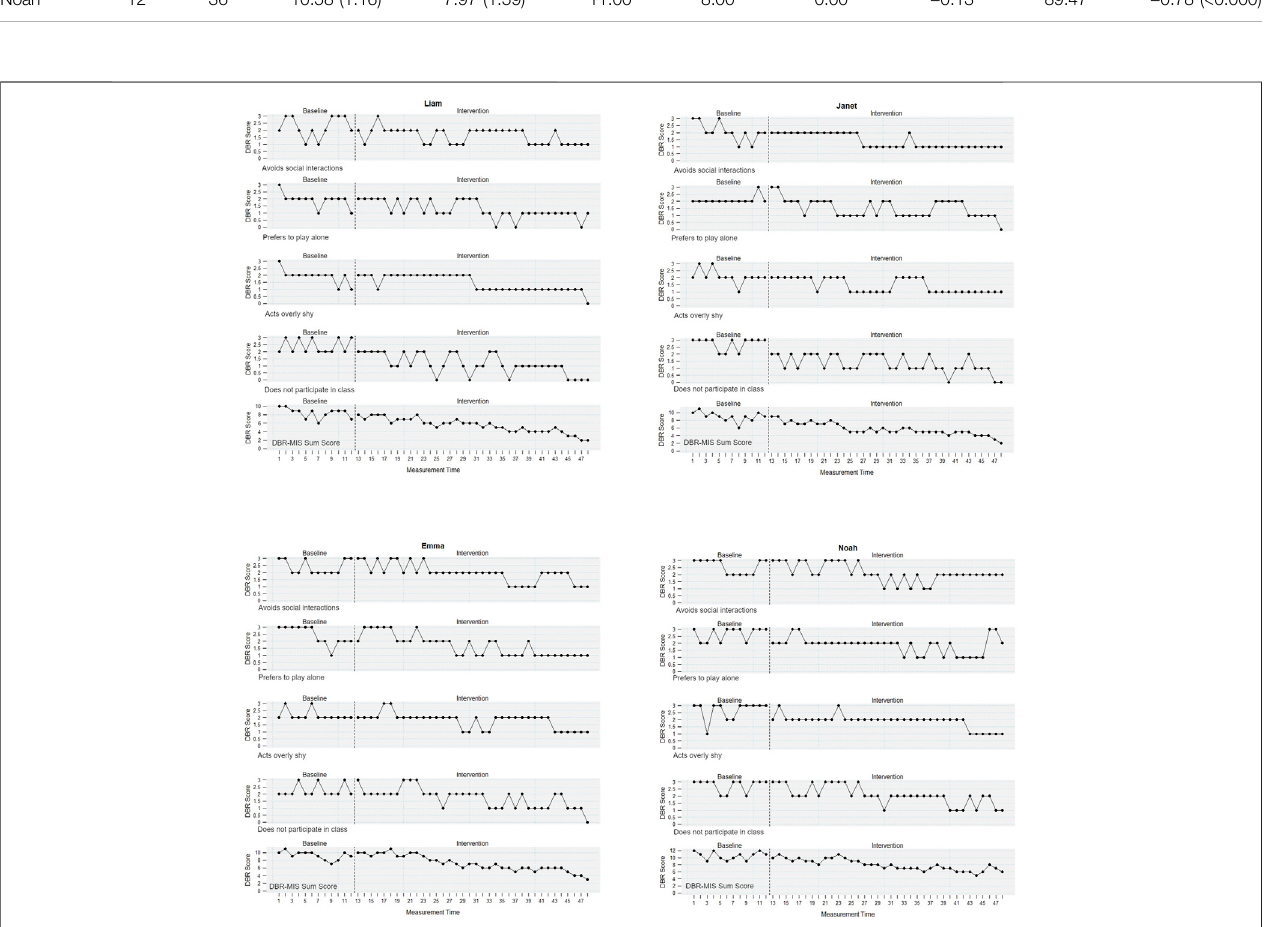
FIGURE 1 | Trajectories of the socially anxious classroom behavior for all four students during A- and B-phase.